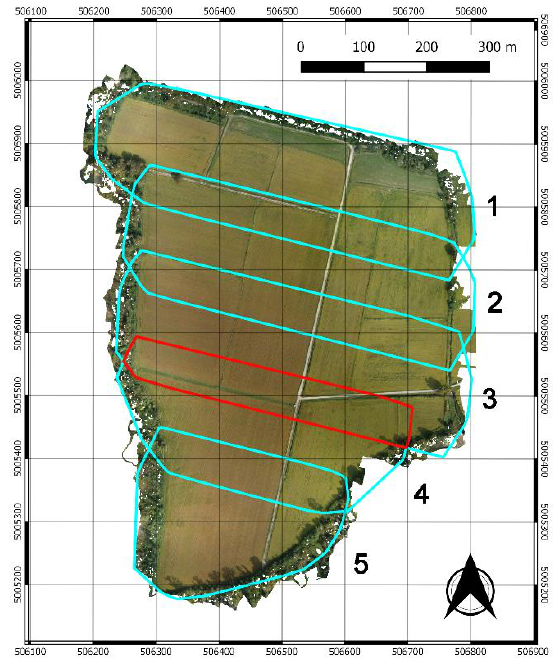
Figure 2. The sub-block compositions in which light blue lines represent the flight outlines; overlapping areas are clearly visible. Area considered in the paper is highlighted in